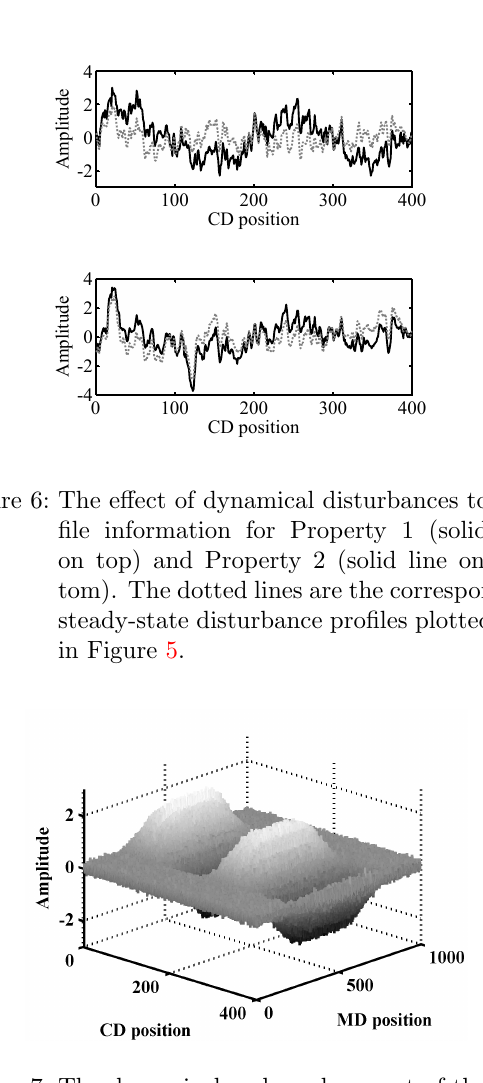
Figure 7: The dynamical and random part of the sim- ulated variations.